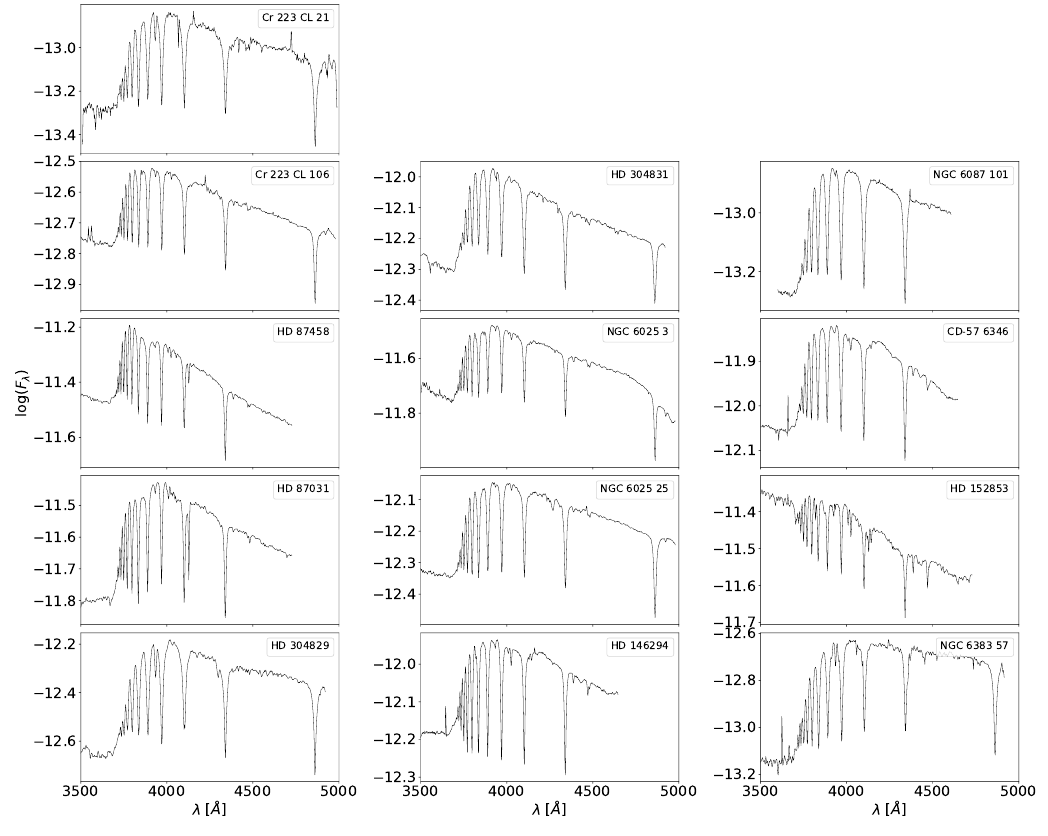
Figure 8. Low-resolution flux-calibrated spectra taken in CASLEO for Bdd stars in clusters. Adapted from Aidelman et al. [144].